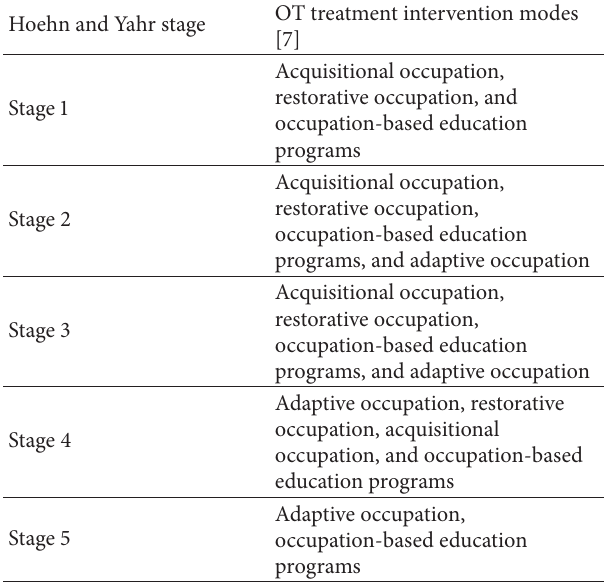
Table 1: OT treatment intervention modes as related to the Hoehn and Yahr scale